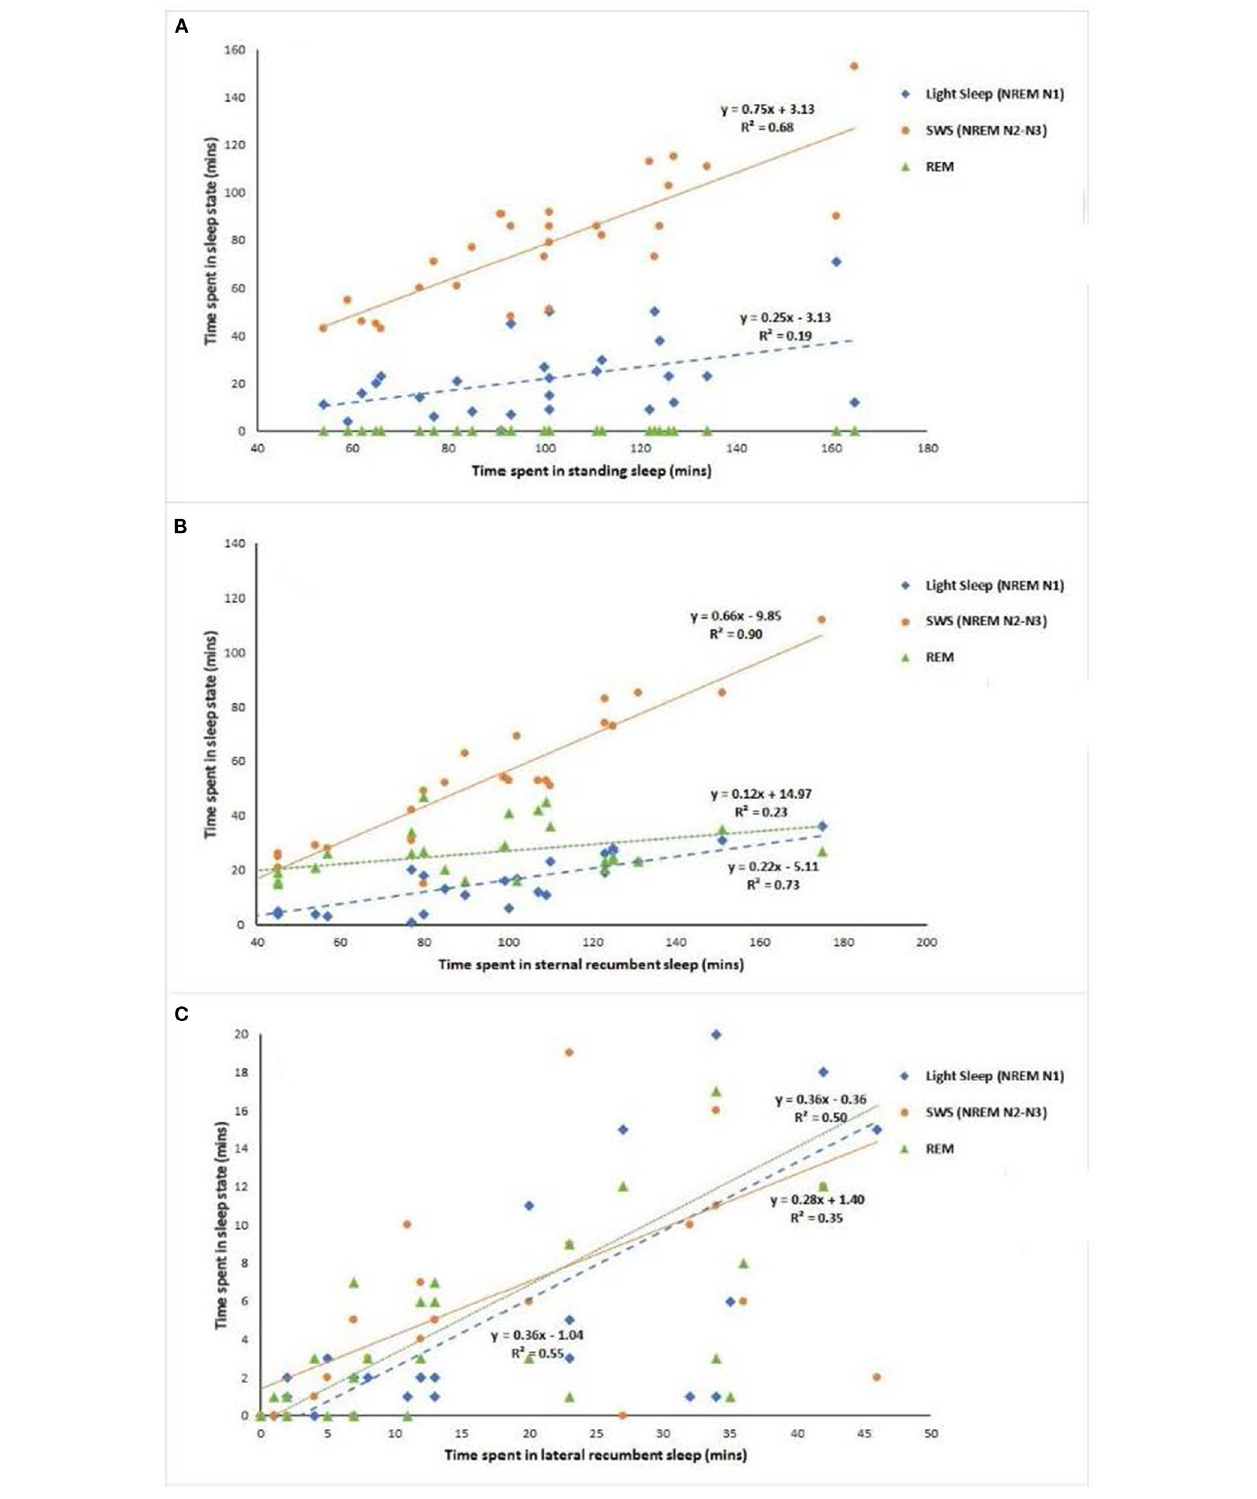
FIGURE 3 | Linear regression analysis of average duration EEG sleep states against average duration behavioral states for 7 horses over 4 nights. Data taken from Kalus (42) [ (A) standing, (B) sternal recumbency, (C) lateral recumbency].